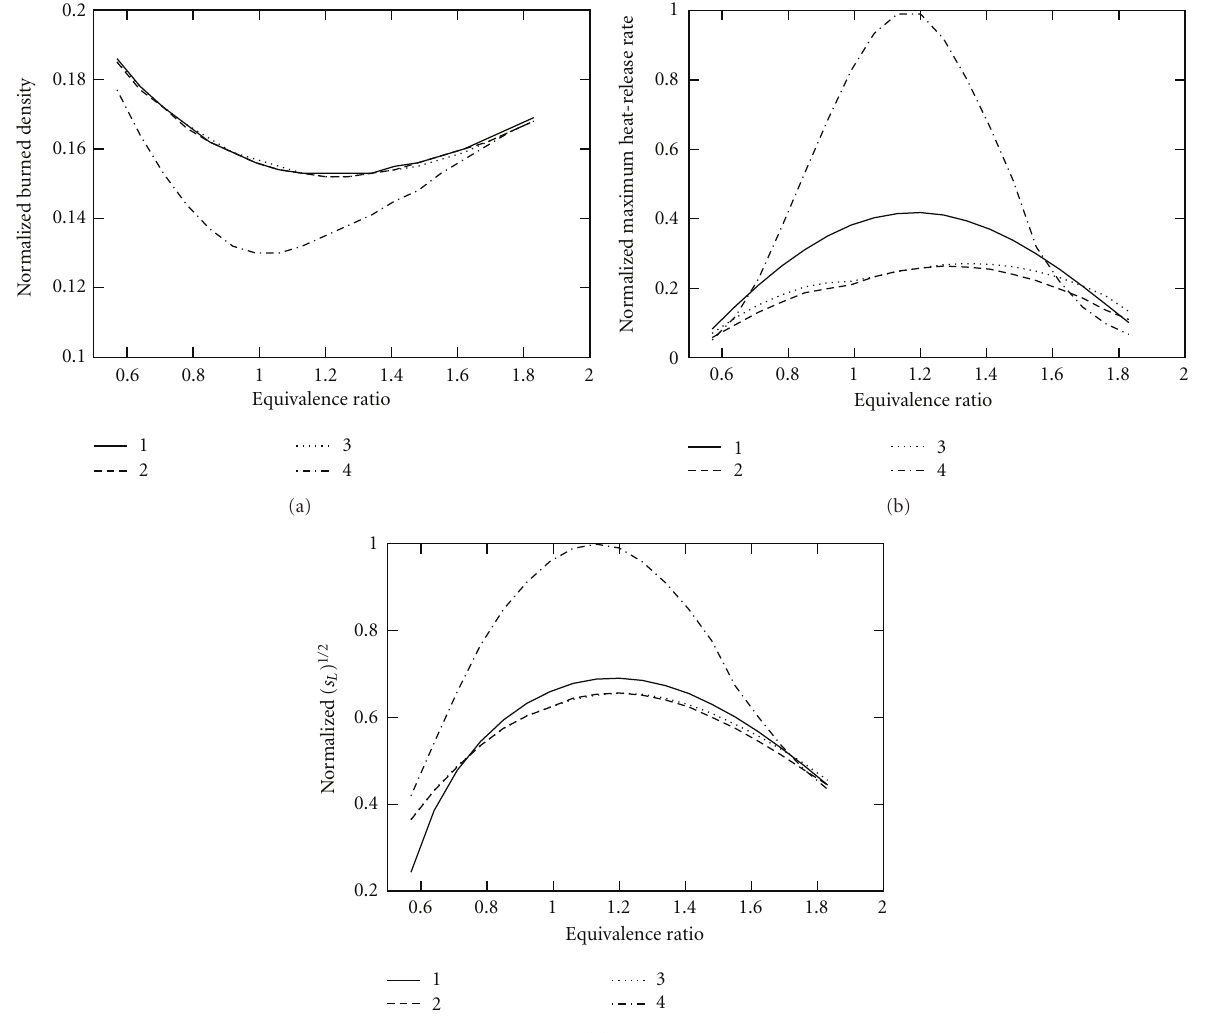
Figure 14: Dependencies of the normalized mean density ρ of burned gas (a), the normalized maximum heat release rate ω (b), and the b of the normalized laminar flame speed (c) on the mean equivalence ratio F , calculated either invoking the beta-function square root s 1 / 2 L (curves 1), the R-2 δ (curves 2), and 2 δ (curves 3) PDFs, or neglecting fluctuations in the mixture composition (curves 4). F min = 0 . 5 and F max = 1 . 9, g f = 0 .